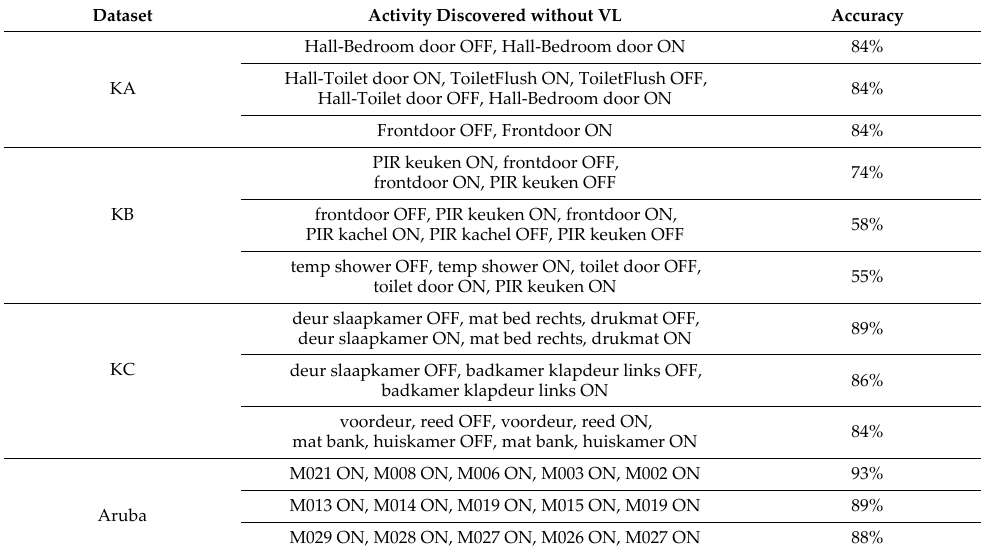
Table 5. Results of activity discovery in each dataset without virtual location.